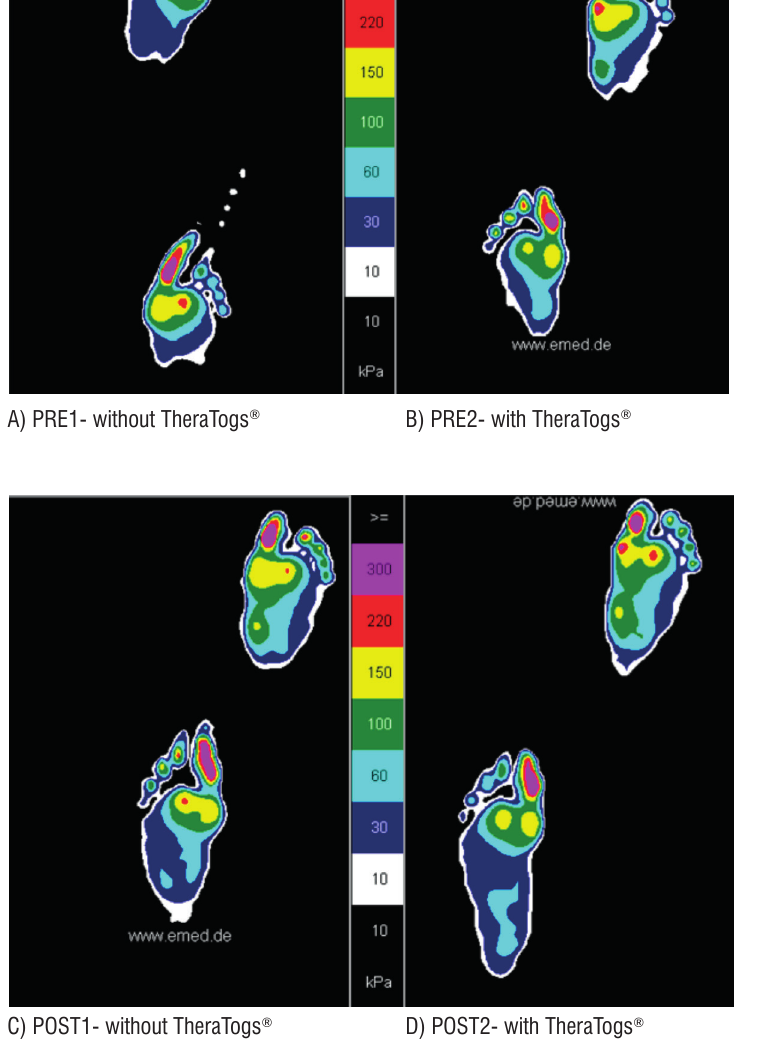
Figure 2 - Plantar pressure distribution, with and without TheraTogs®, in assessments before and after the intervention